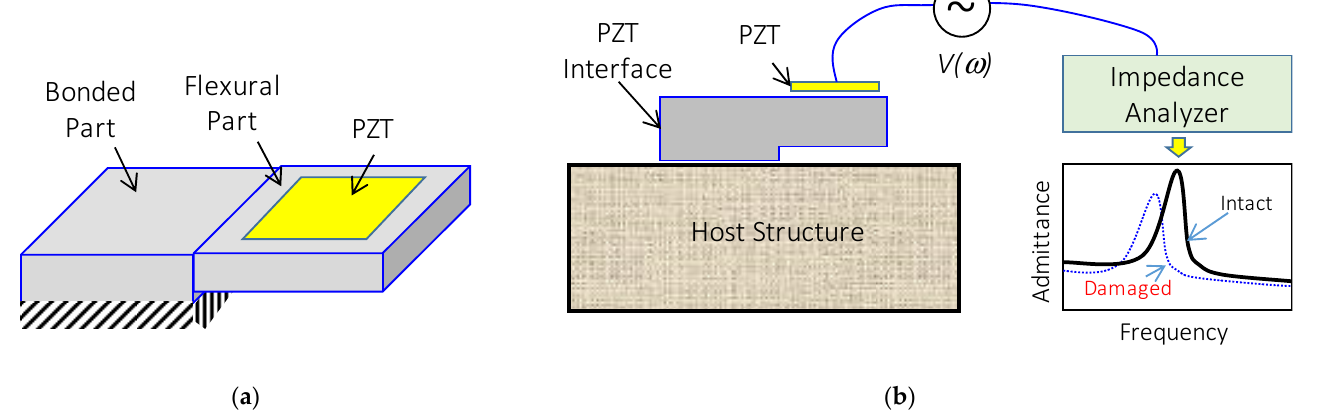
Figure 1. Admittance monitoring technique using a single-point mount PZT interface. ( a ) Prototype; ( b ) Admittance measurement process.